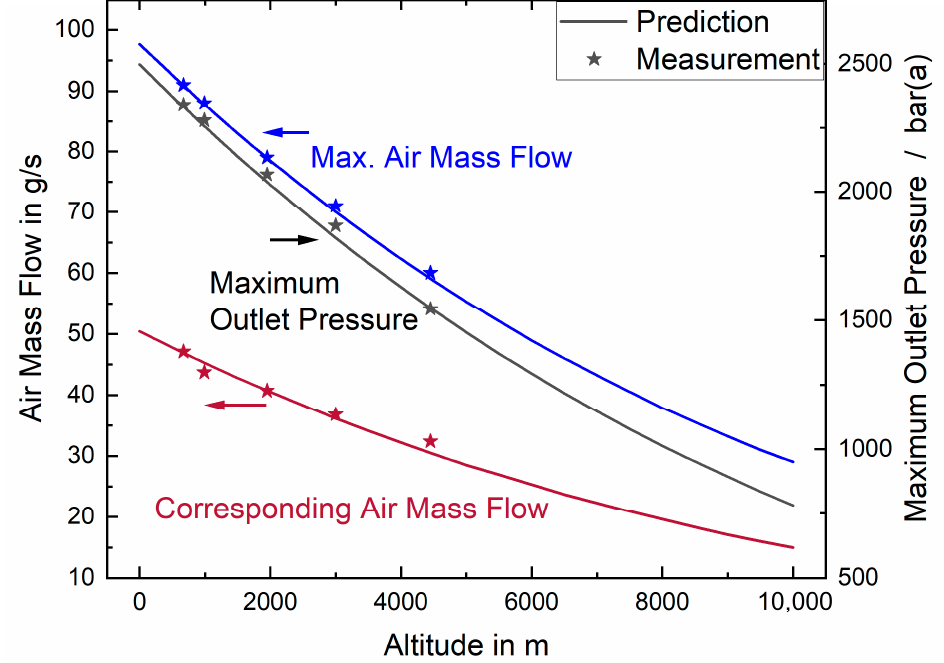
Figure 7. Predicted maximum pressure ratio with corresponding air mass flow and maximum air mass flow for the Rotrex EK10AA; measurement data are plotted in stars for comparison.